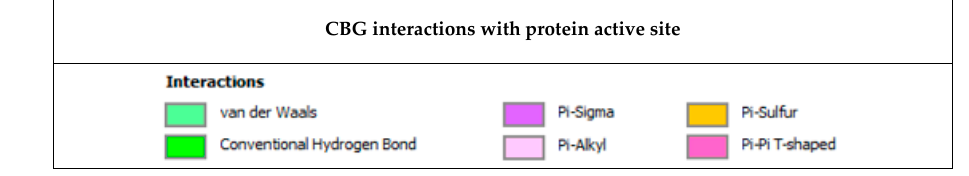
Figure 8. Interactions of the docked compounds, CBD and CBG. The 2D orientations of both docked compounds are shown. The putative interactions with neurokinin 3 receptor (NK3R) are shown with different colors.